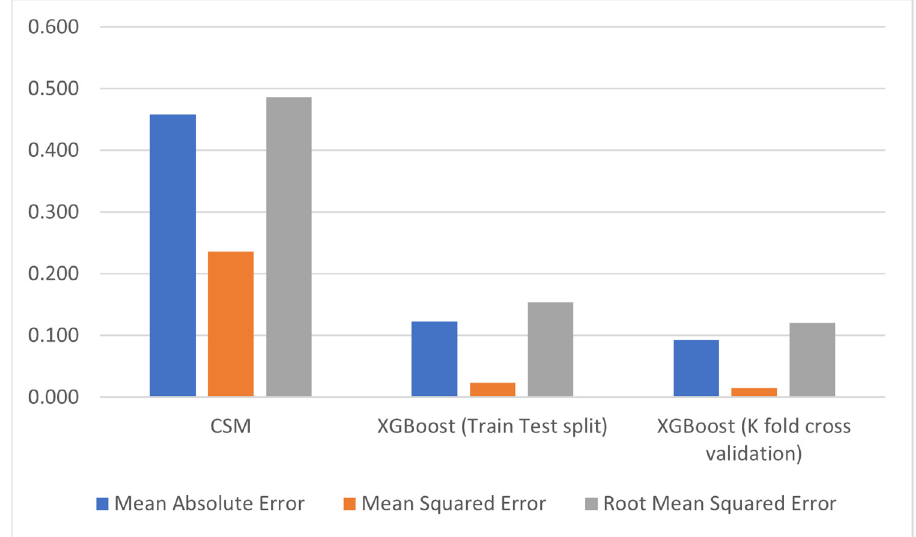
Figure 9. Difference between simulation errors and ML